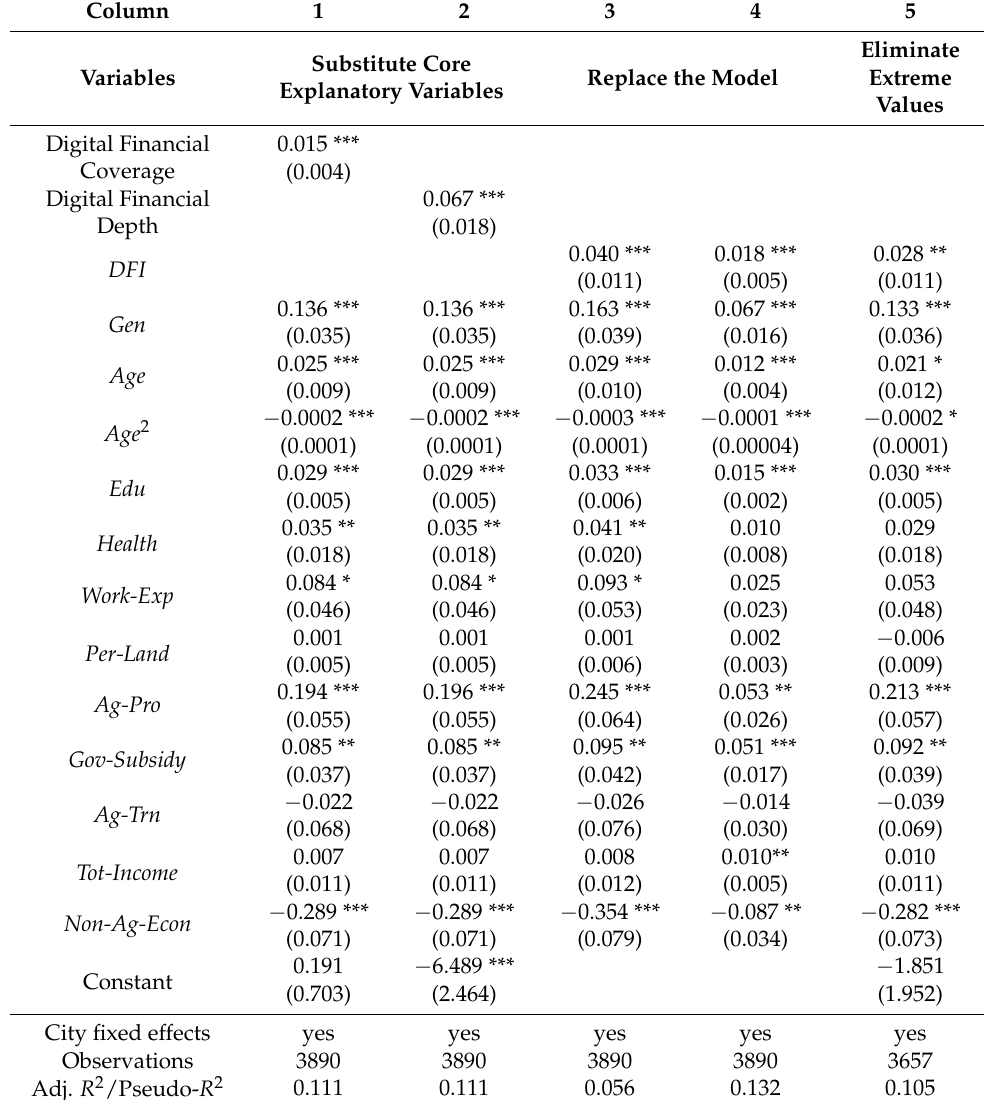
Table 4. Robustness test.